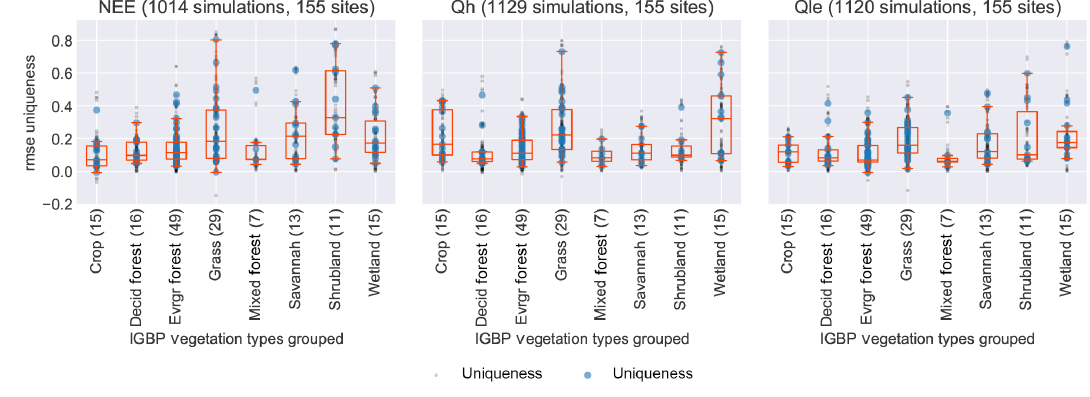
Figure 6. RMSE uniqueness for vegetation type (grouped; see